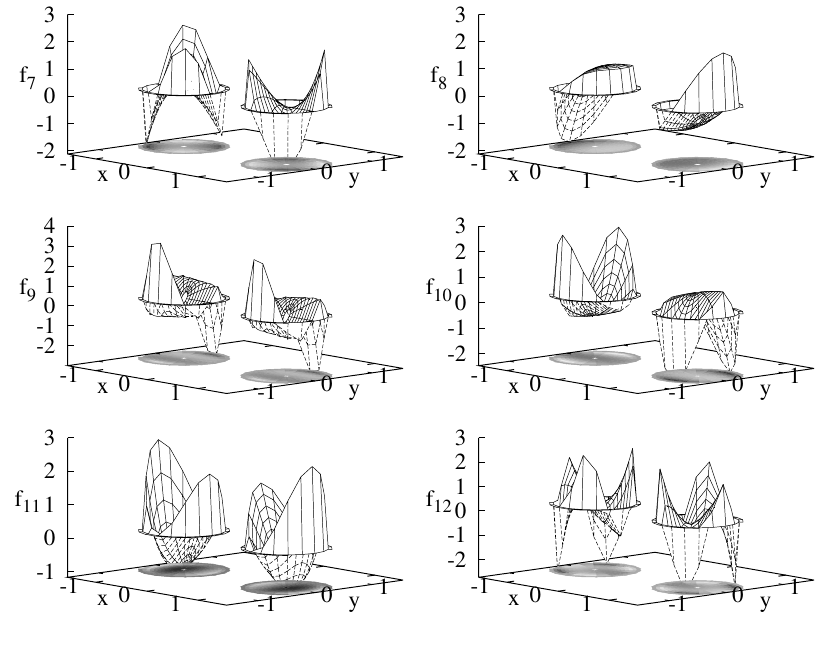
Fig. 3. The basis functions f 7 to f 12 for q = 1 =